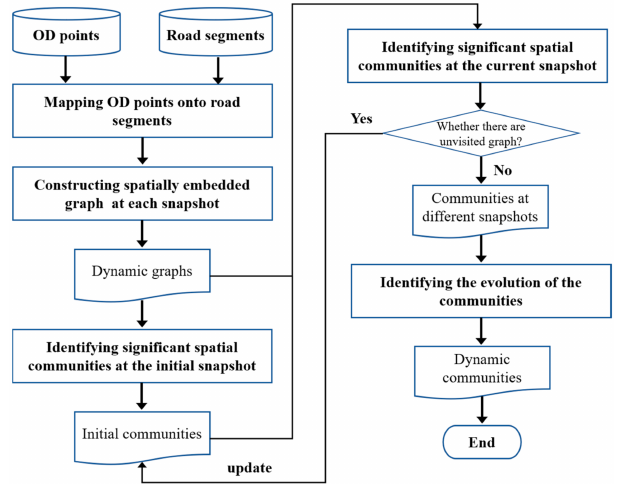
Figure 1. Framework of the proposed